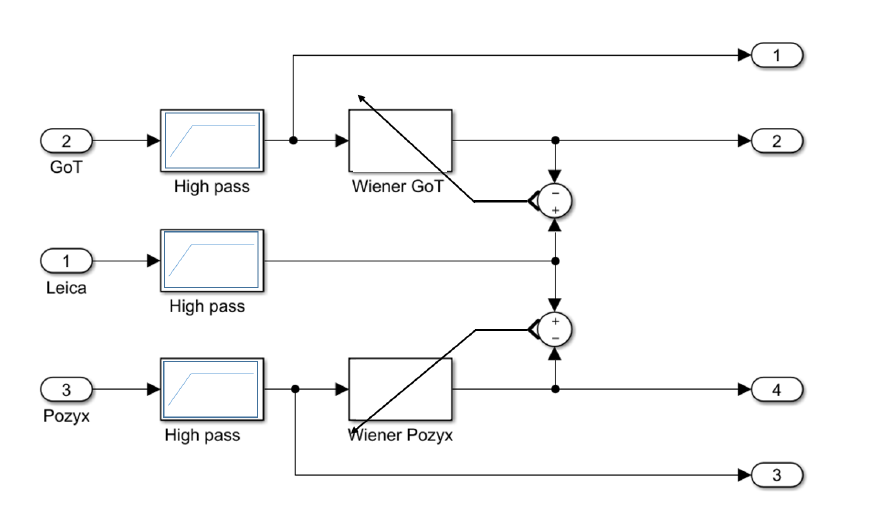
Figure 14. Use of high-pass pre-filtering and Wiener filtering during error analysis.